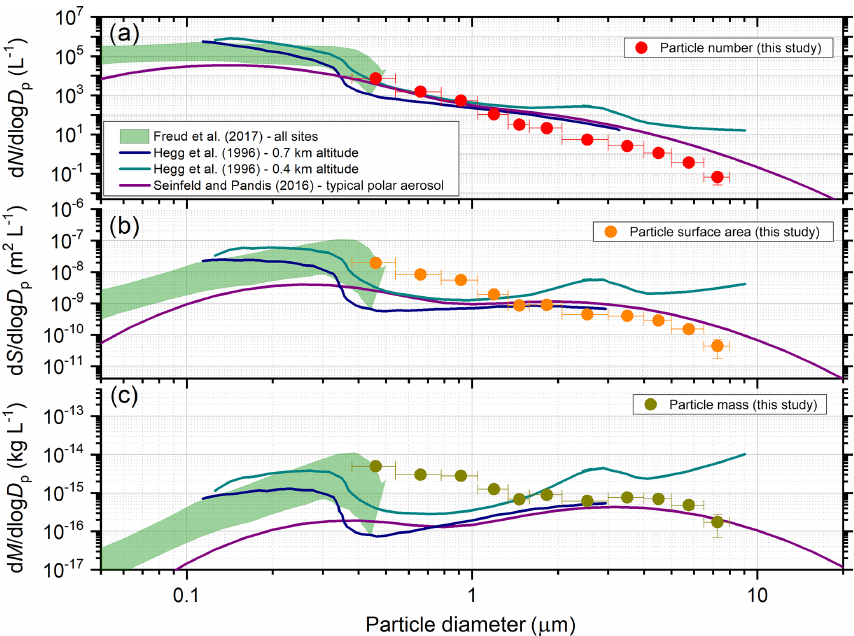
Figure 5. Size distribution data produced from OPC measurements. (a) Particle number, (b) particle surface area, and (c) particle mass size distribution data above the surface temperature inversion during a test run of the SHARK suite whilst deployed on a tethered balloon in the High Arctic. Comparisons to previous studies at Arctic sites are shown (Freud et al., 2017; Hegg et al., 1996; Seinfeld and Pandis, 2016). The August aerosol number size distributions for all listed sites in Freud et al. (2017) including Zeppelin, Nord, Alert, Barrow, and Tiksi are shown. The data from Hegg et al. (1996) at altitudes of 0.7 and 0.4km in Prudhoe Bay, Alaska, are presented. The size distributions from Seinfeld and Pandis (2016) are calculated given the parameters for multimode distributions given in their Table